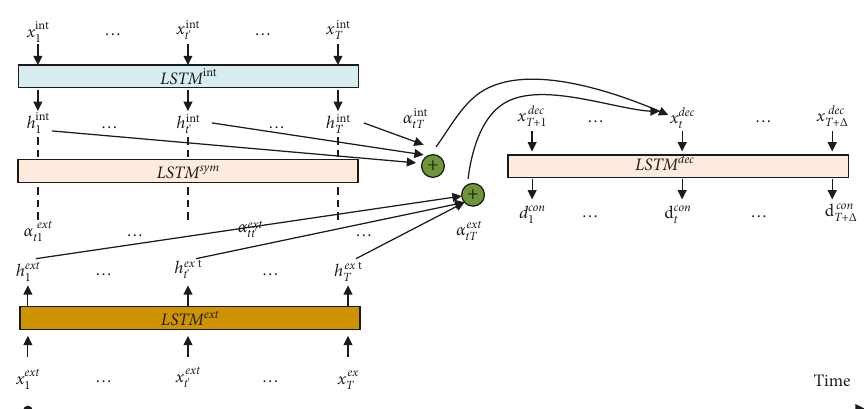
Figure 7: Demonstration of attention mechanism for weighted input